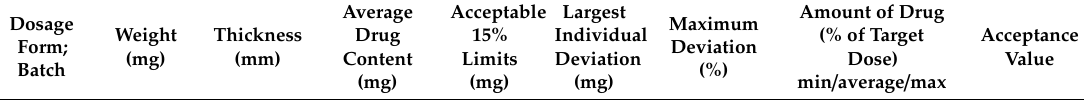
Table A1. Drug content, content uniformity, uniformity of dosage units (acceptance value, according to Ph.Eur 9th ed.), and dose accuracy compared to target doses for the various batches prepared by di ff erent manufacturing techniques. Drug content is expressed as average ± SD, n = 10, while AV and UC are calculated based on 10 dosage forms from each batch. Note that the weight of the OPSs are given without a decimal as that is how it is routinely done when manufacturing OPS in the hospital pharmacy. The weight of the ODFs are, however, given with one decimal to show di ff erences between the dosage